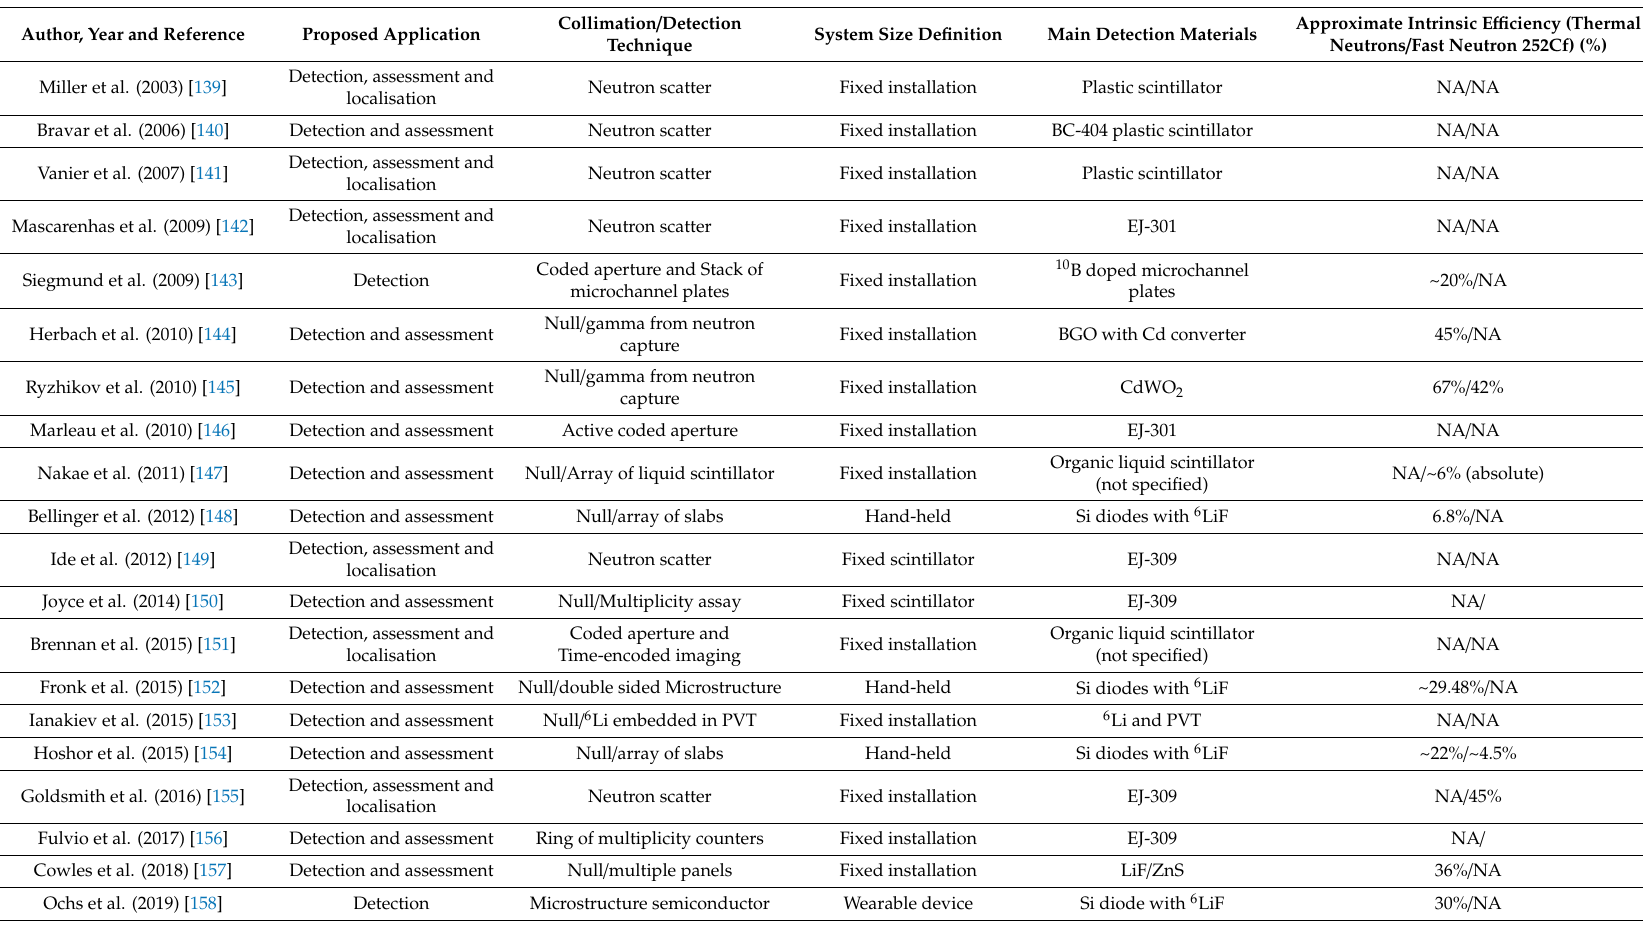
Table 4. Examples of neutron imaging systems used in nuclear materials security, their collimation technique, properties and